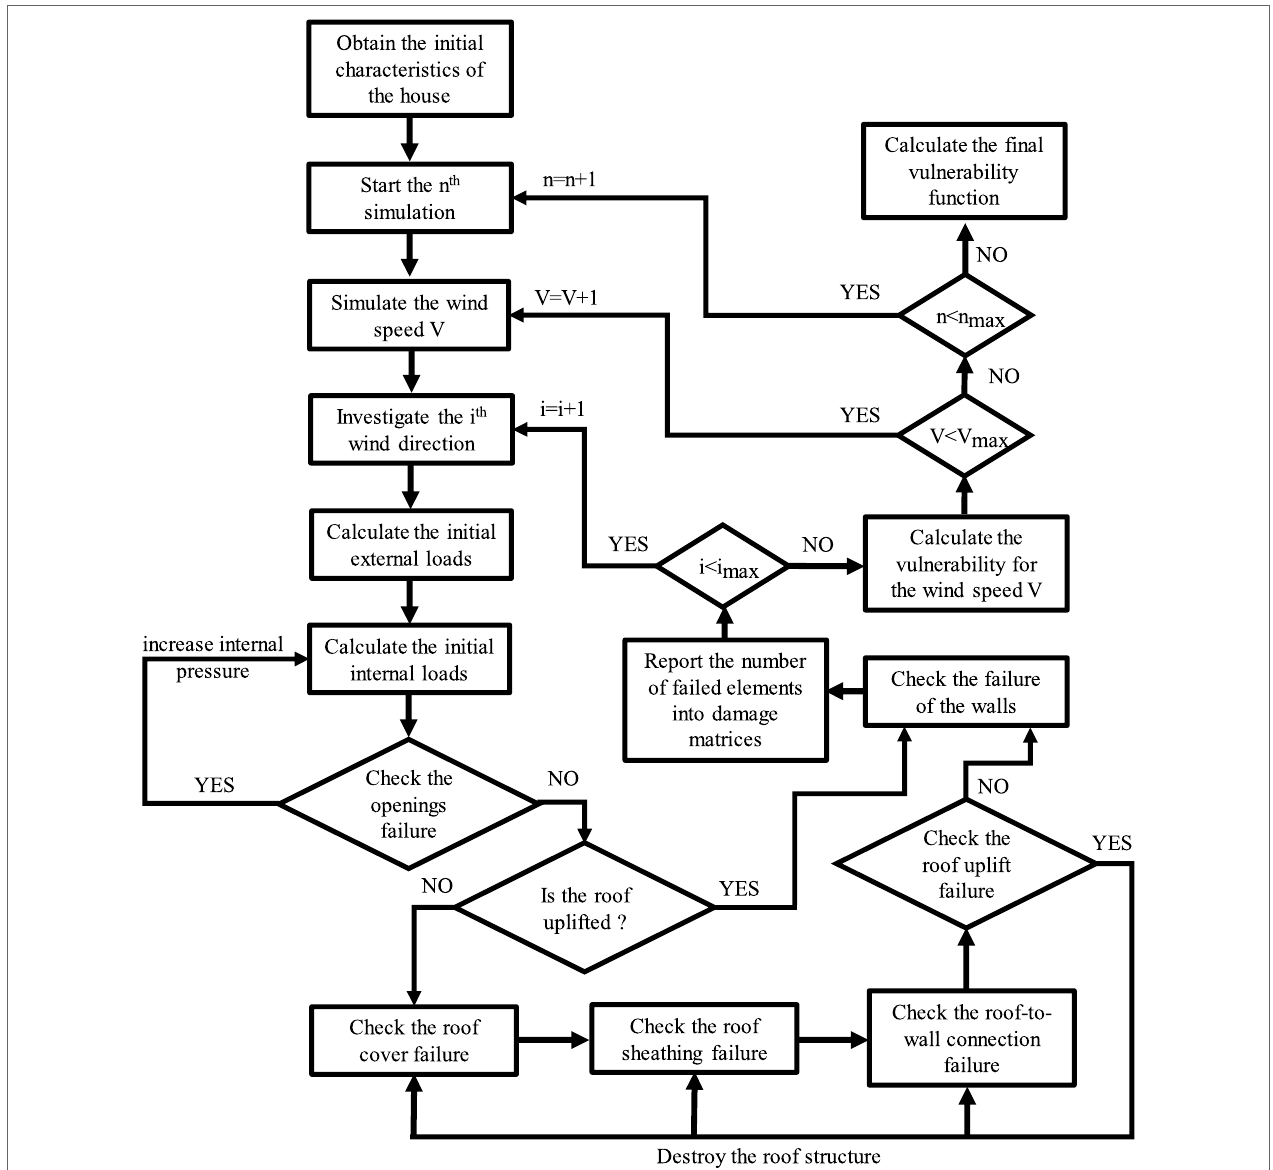
FigUre 1 | The algorithm of the vulnerability